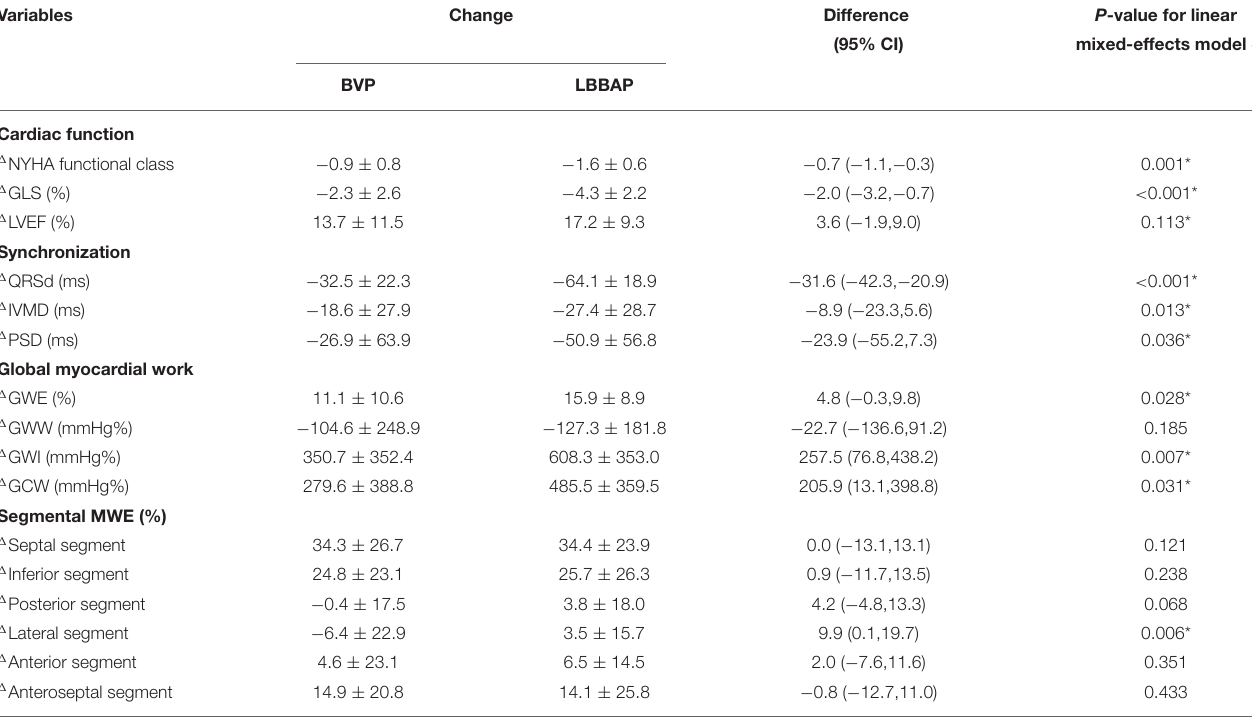
(95% CI) mixed-effects model #